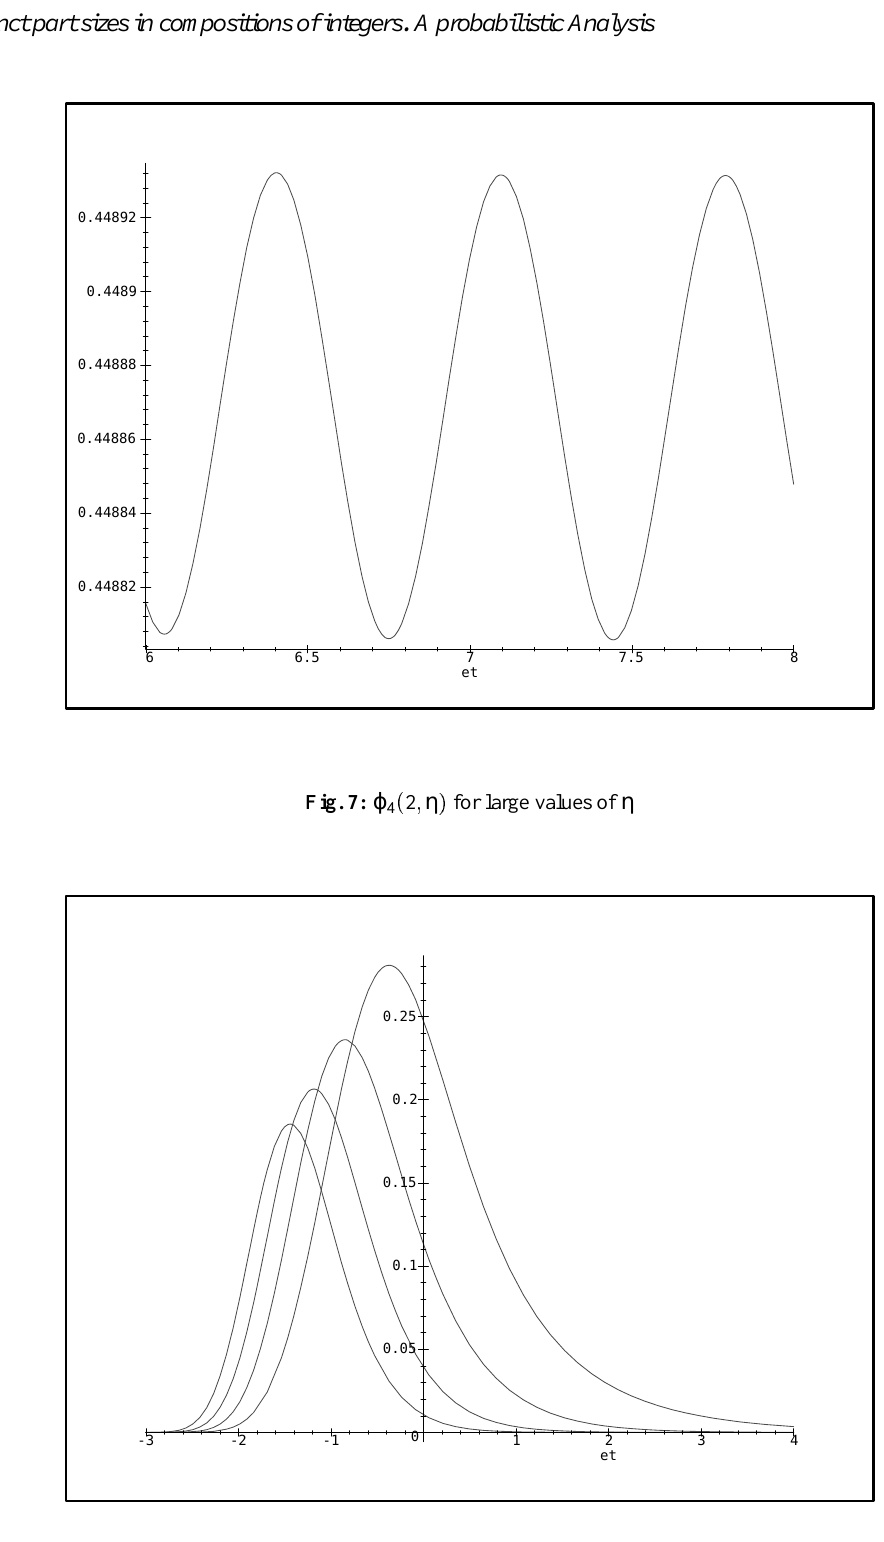
h for m (cid:5) (cid:1)